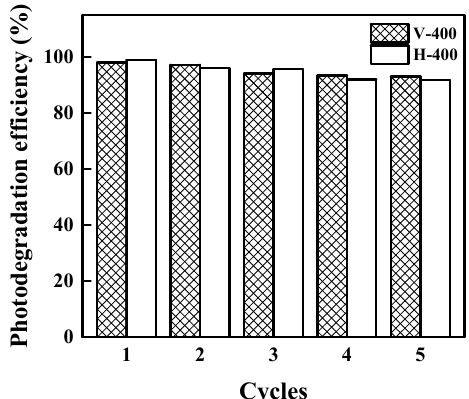
Figure 10. MB degradation efficiency (%) by H-400 and V-400 under AM 1.5 G solar light irradiation at different cycles.